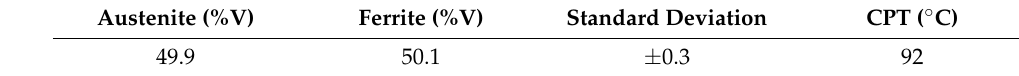
Table 3. Base metal phase balance.